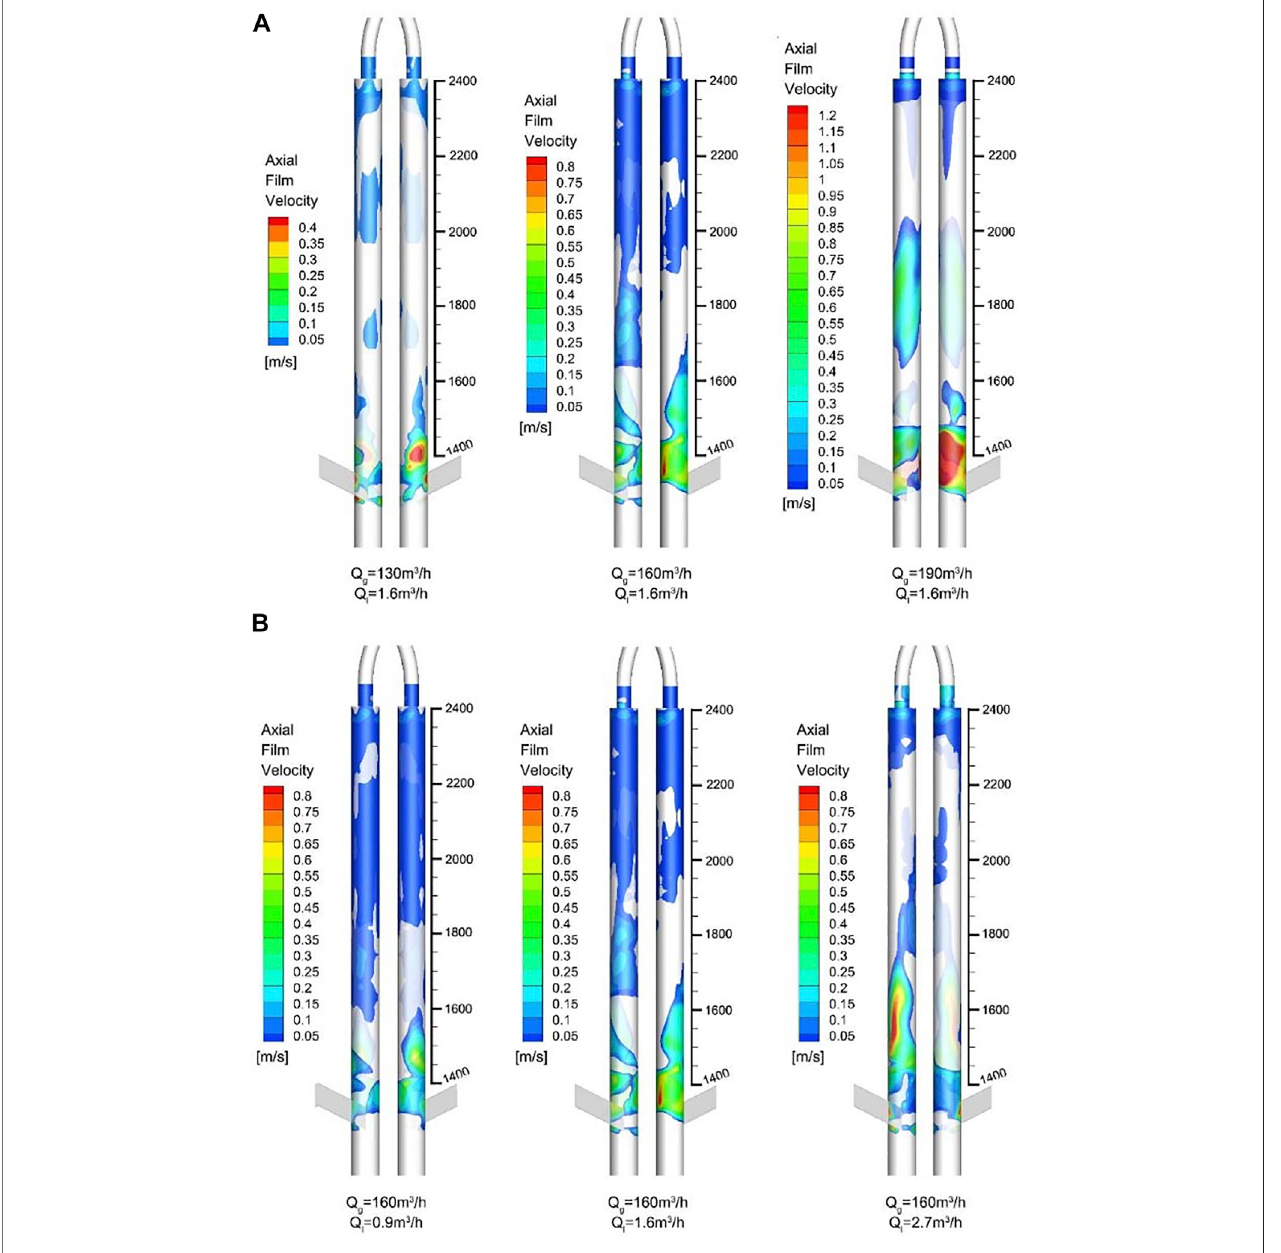
FIGURE 8 | Contours of USLF axial fi lm velocity under different (A) gas fl owrates and (B) liquid fl owrates.